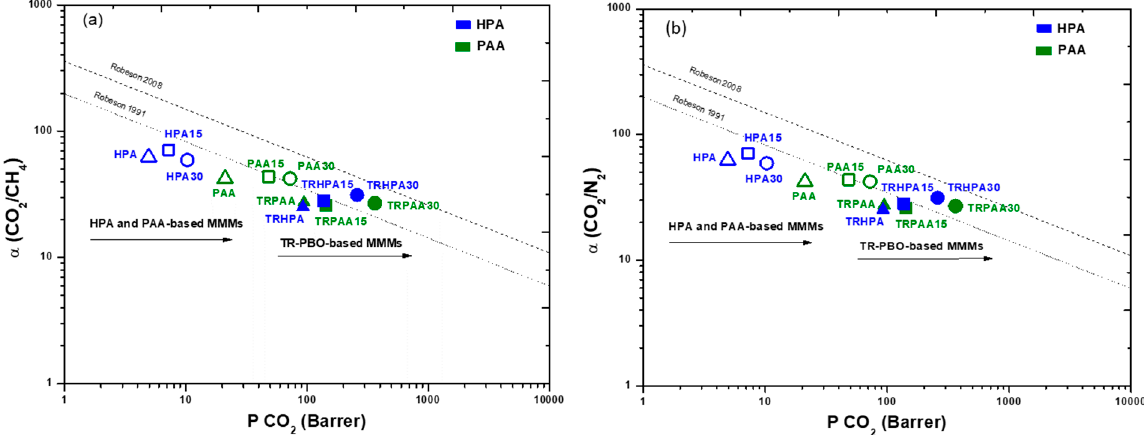
Figure 10. Upper bound limit plot for ( a ) CO 2 /CH 4 and ( b ) CO 2 /N 2 separation by MMMs based on PAA (solid symbols, green) and HPA (solid symbols, blue). The filler contents were 0 weight % (triangle), 15 weight % (square) and 30 weight % (circle). Lines correspond to the 1991 and 2008 Robeson upper bounds [44,45]. (a) corresponds to the CO 2 /CH 4 gas pair and (b) corresponds to the CO 2 /N 2 pair. Note that 1 Barrer = 10 − 10 cm 3 (STP) · cm)/(cm 2 · s · cmHg) = 3.35 · 10 − 16 mol · m/(m 2 · s · Pa). Measurements were performed at 35 °C and 3·10 5 Pa.